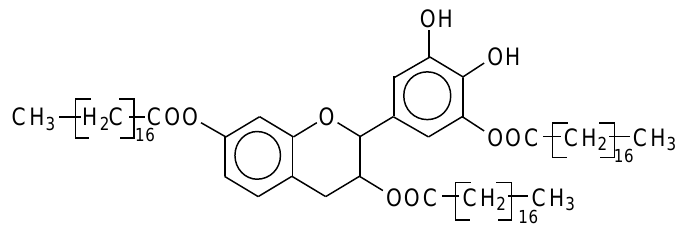
Figure 7. Examples of the structure of a robinetinidin-(oleate) 3 , with Na+.